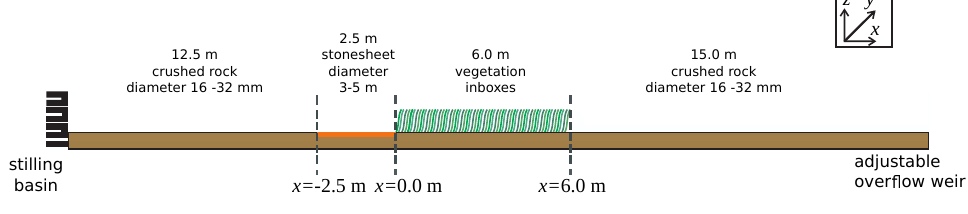
Figure 3. Experimental setup and definition of the coordinate axes (not to scale) (taken from Järvelä